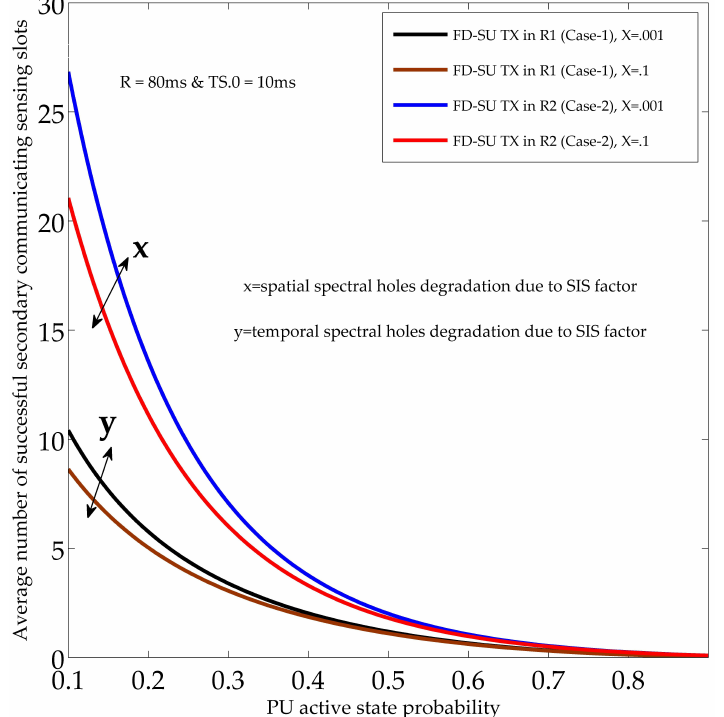
Figure 8. Average number of secondary communicating sensing slots with different PU active state probabilities and SIS